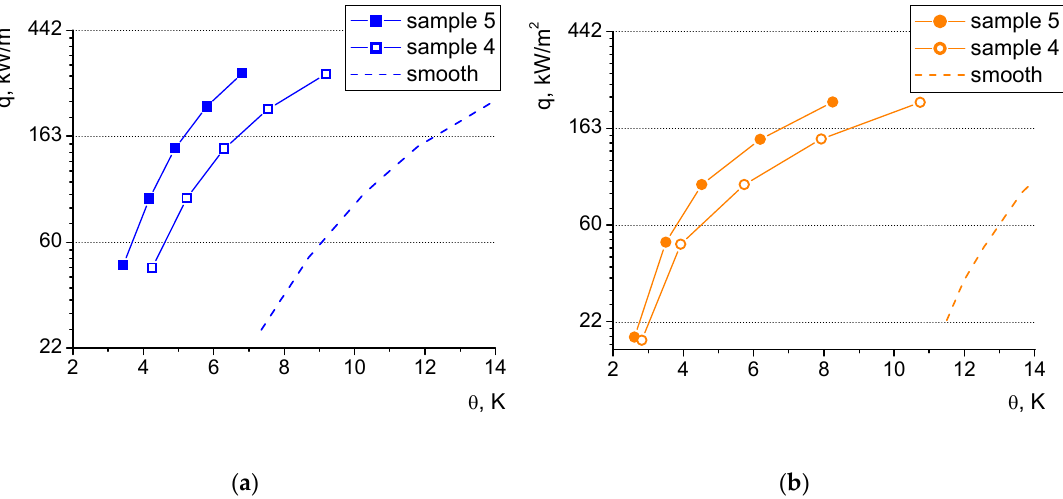
Figure 11. Comparison of the boiling curves for the most (sample 5) and least (sample 4) efficient laser textured surfaces and the smooth reference surface; ( a ) distilled water, ( b ) ethyl alcohol.